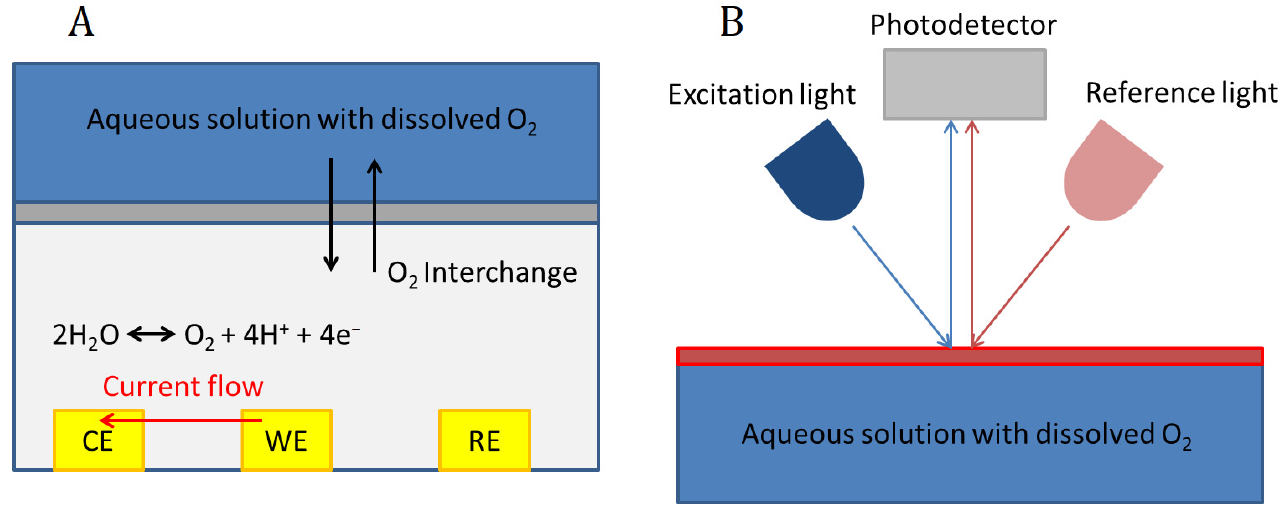
Figure 2. Dissolved oxygen sensors working principle. Electrochemical sensor ( A ); Optical sensor ( B ).